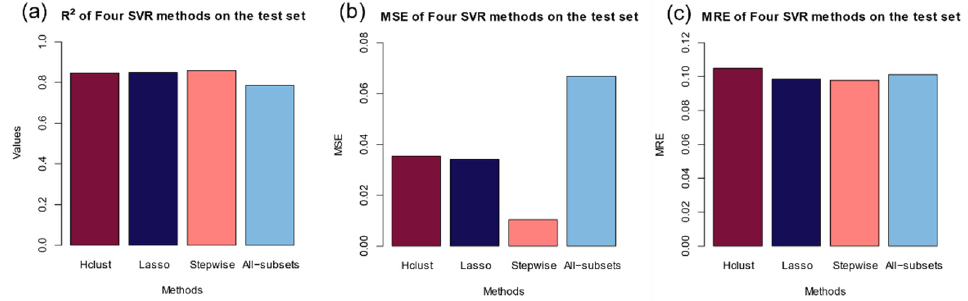
Figure 8. The R 2 , MSE and MRE on the test set. ( a ) R 2 ; ( b ) MSE; ( c ) MRE. Table 9. The R 2 , MSE and MRE of the four methods on the test set. Methods